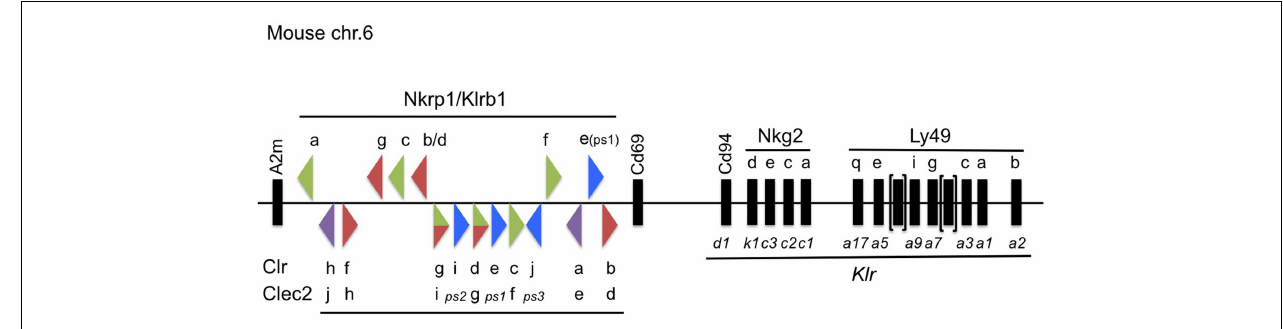
and their color signifies the known or suspected function of the gene products in regulating NK cell activity, as follows: co-stimulatory (green); co-inhibitory (red); bifunctional (green/red); pseudogene ( ps , blue); or unknown (purple). Other select NK receptor genes located telomeric to Cd69 are also depicted with common and official ( Klr ) gene nomenclatures. Not to